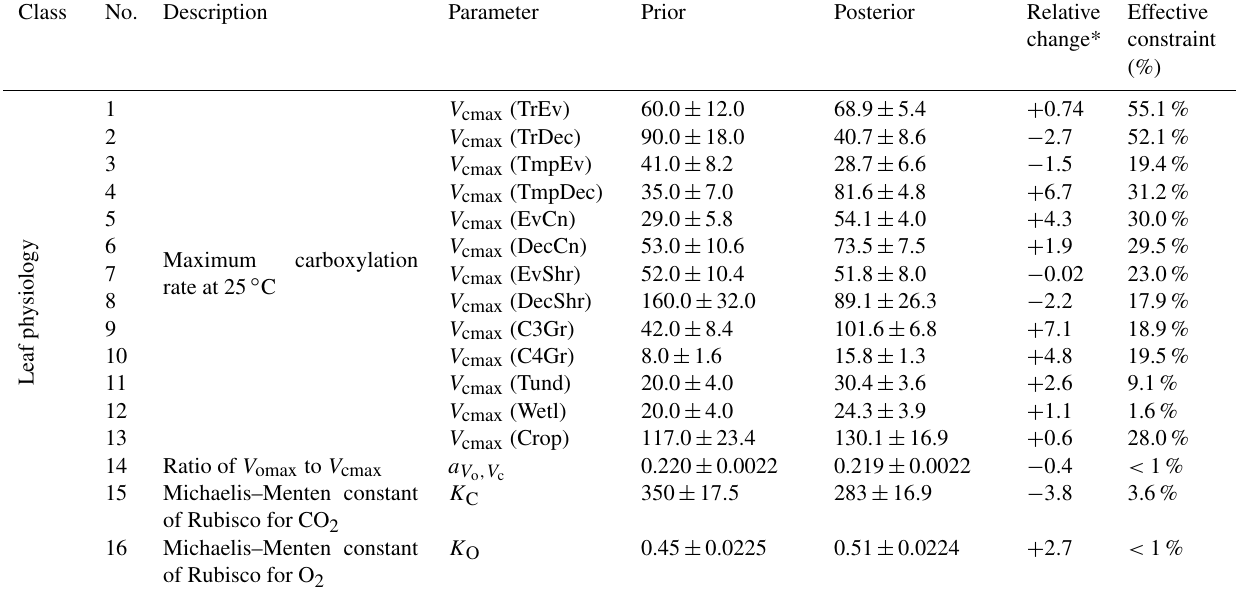
, dimensionless ratio; K C , µbar; K O , bar; C ab o ,V c